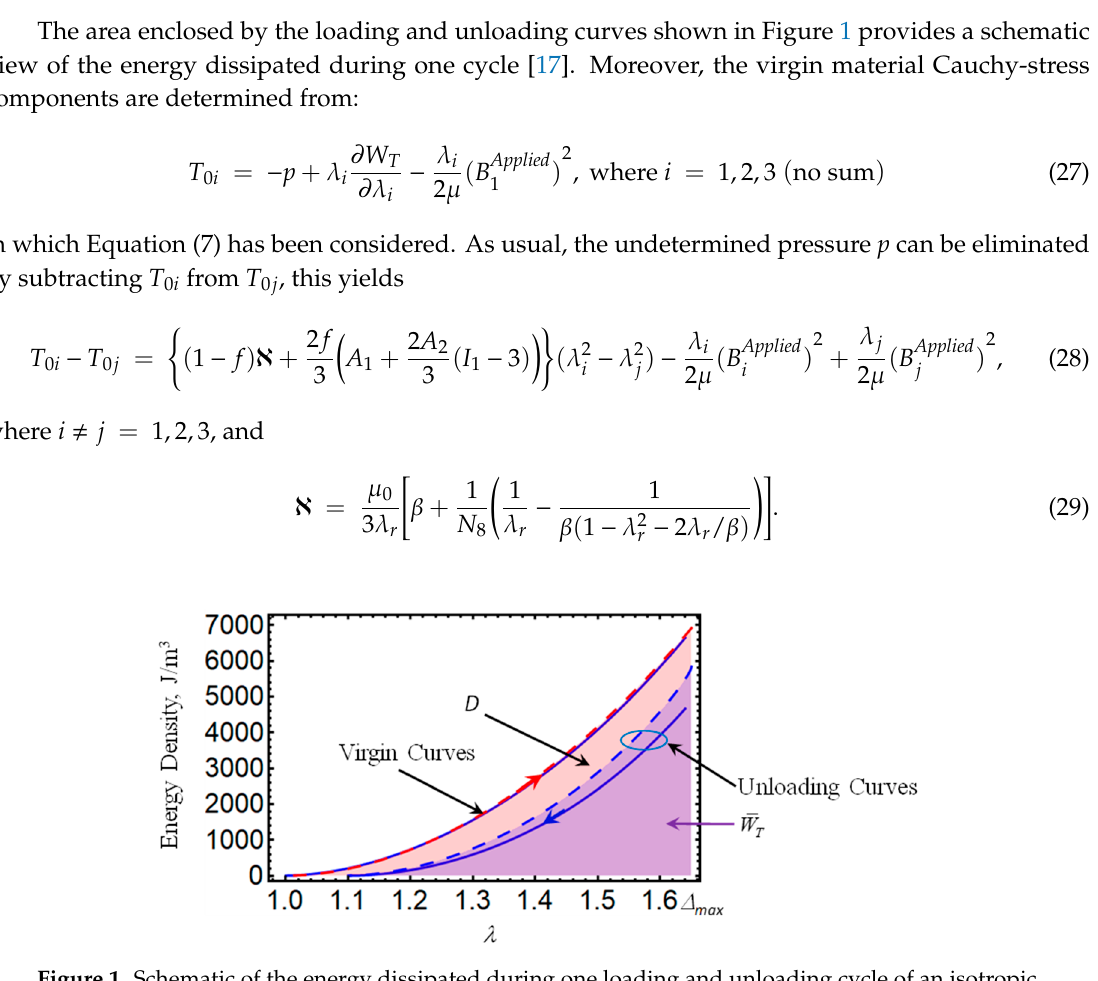
Figure 1. Schematic of the energy dissipated during one loading and unloading cycle of an isotropic magnetorheological polyurethane elastomer reinforced with 35 wt% of carbonyl iron microparticles. Notice that the value of D depends upon the point on the virgin curve at which the unloading process starts. Here B = 0, µ 0 = 13060 Pa, N 8 = 2.5, f = 0.076, b = 0.00275 m 3 / 2 J 1 / 2 , A 1 = 10000, A 2 = 30000, d = 0.0002 m 2 / N, and ∆ a = 1.65.